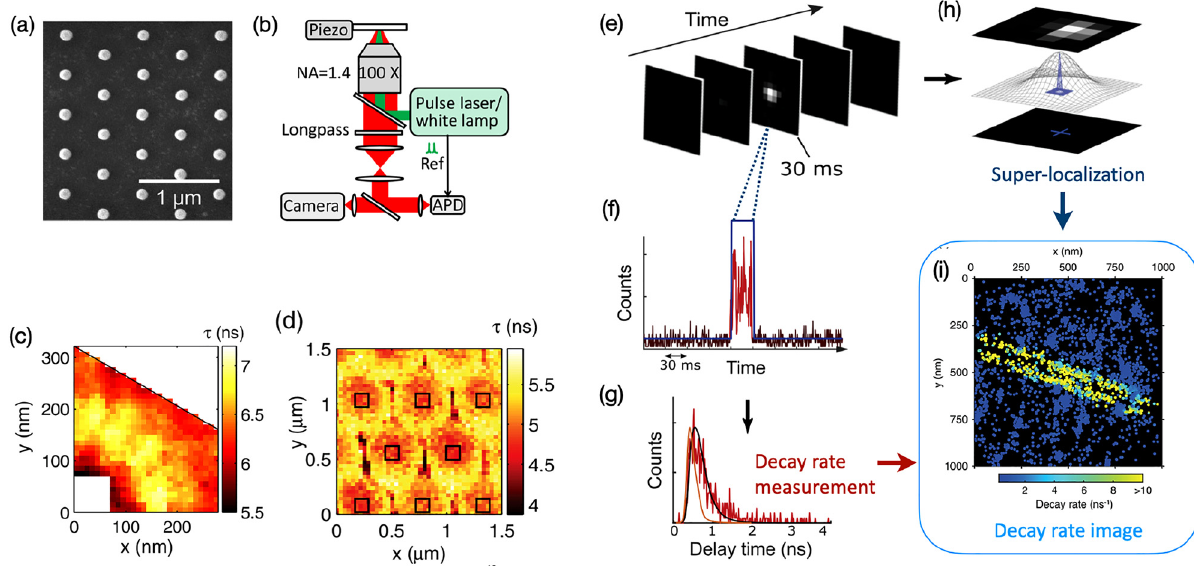
Figure 6: Lifetime-based single-molecule experiments to study light-matter interaction at the nanoscale. (a–d) Super-resolved imaging of the decay rate in the near-field of a lattice of aluminum nanoantennas, adapted from [131]. (a) SEM image of a hexagonal lattice of aluminum nanoantennas. (b) Sketch of the experimental setup. (c) Fluorescence lifetime map, obtained with 40 nm fluorescent spheres randomly spread on the sample, of the unitary cell around a nanoantenna. The white square delimits the boundary of the nanoantenna. (d) Fluorescence lifetime map obtained with a SNOM tip, adapted from [131]. (e–i) Illustration of smFLIM applied on a silver nanowire, adapted from [132]. A sequence of EM-CCD frames is acquired (e). The bright spot in the central frame is the PSF of a single molecule. The PSF is fitted with a Gaussian fit and its center is located with a precision of about 10 nm (h). Simultaneously, half of the photons emitted by the molecule are detected on a time-resolved SPAD and a TCSPC device allows to extract the decay rate of the fluorescent emission (f and g). By combining the information on the position and decay rate of each molecule one can reconstruct the decay rate image in the near-field of a silver nanowire